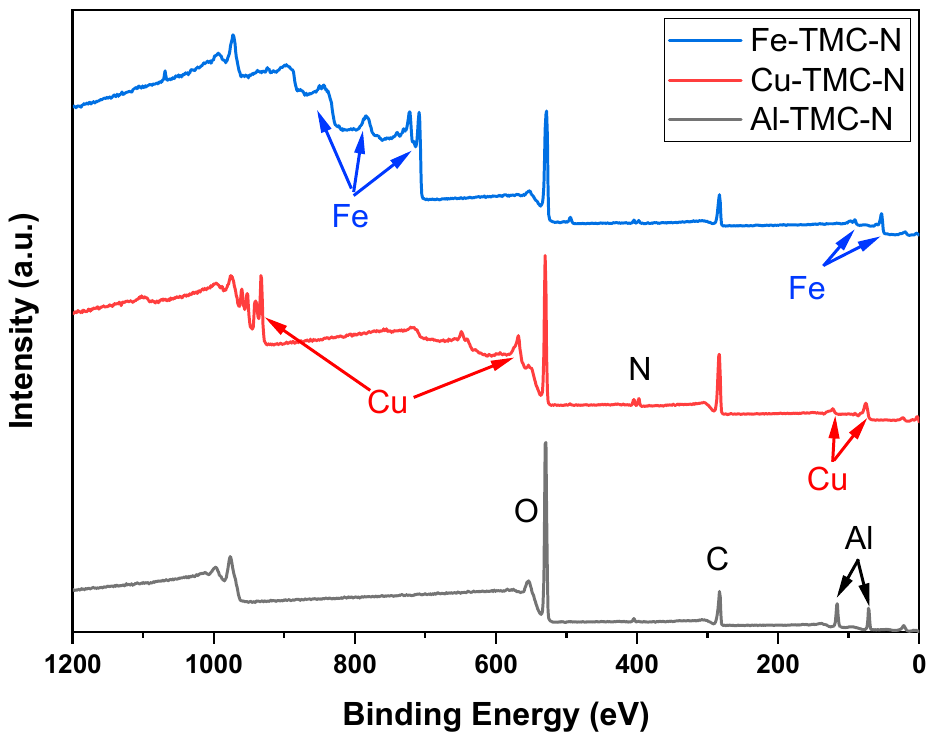
Figure 1. Elemental identification of Fe-TMC-N, Al-TMC-N and Cu-TMC-N. Several elements (Fe, Cu and Al) were found in the respective XPS spectra, with an additional small Na signature in the Fe-TMC-N materials. Cu-TMC-N appears to also contain more nitrate than the other TMC